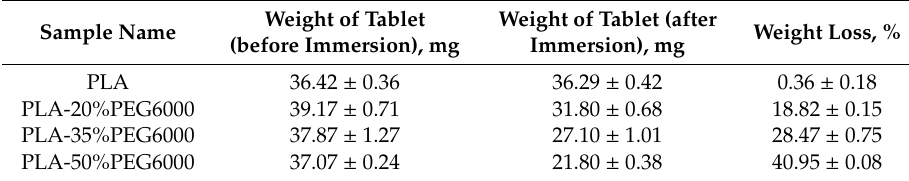
Table 4. Weight loss of PLA / PEG / MB tablets after 120 days